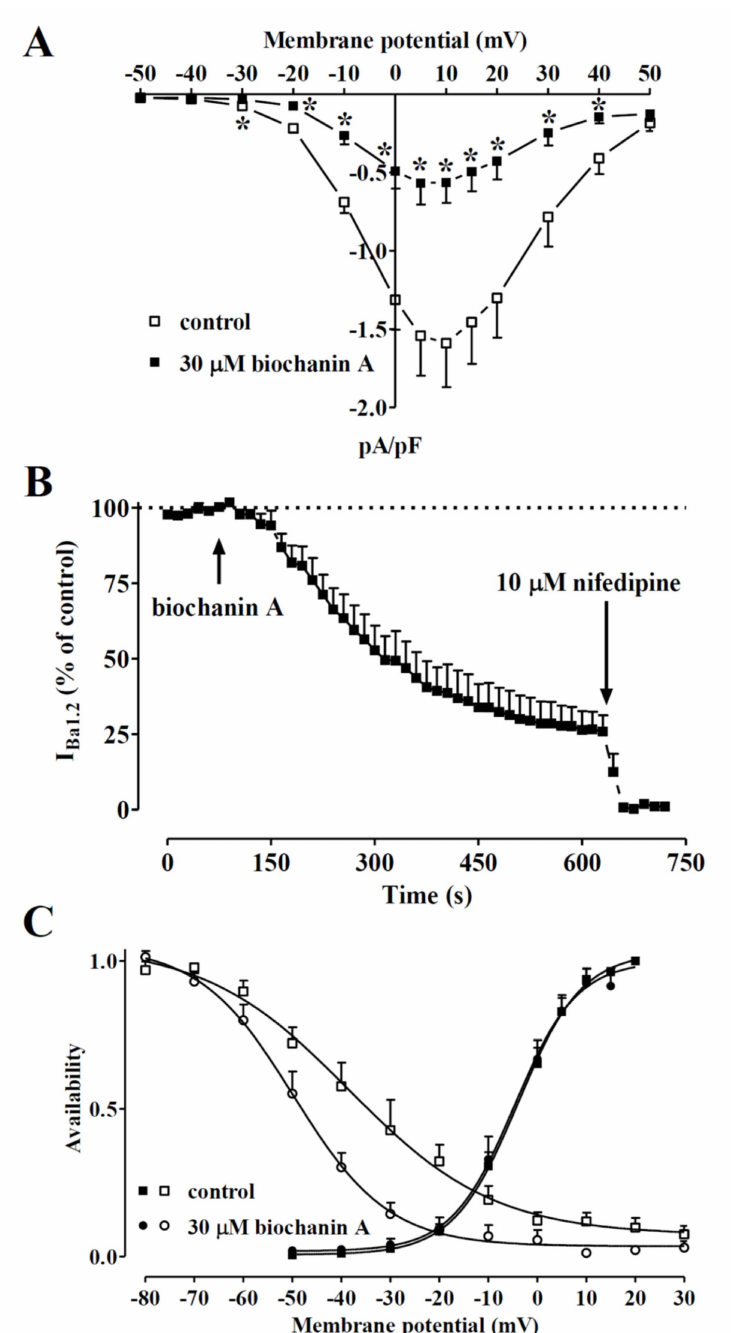
Figure 5. Voltage dependency of biochanin A-induced inhibition of I Ba1.2 in single tail artery myocytes. ( A ) Current–voltage relationships, recorded from a V h of − 50 mV, constructed before the addition (control) and in the presence of 30 µ M biochanin A. Data points are the mean ± SEM ( n = 5). * p < 0.05 vs. control, Student’s t -test for paired samples. ( B ) Time course of I Ba1.2 inhibition induced